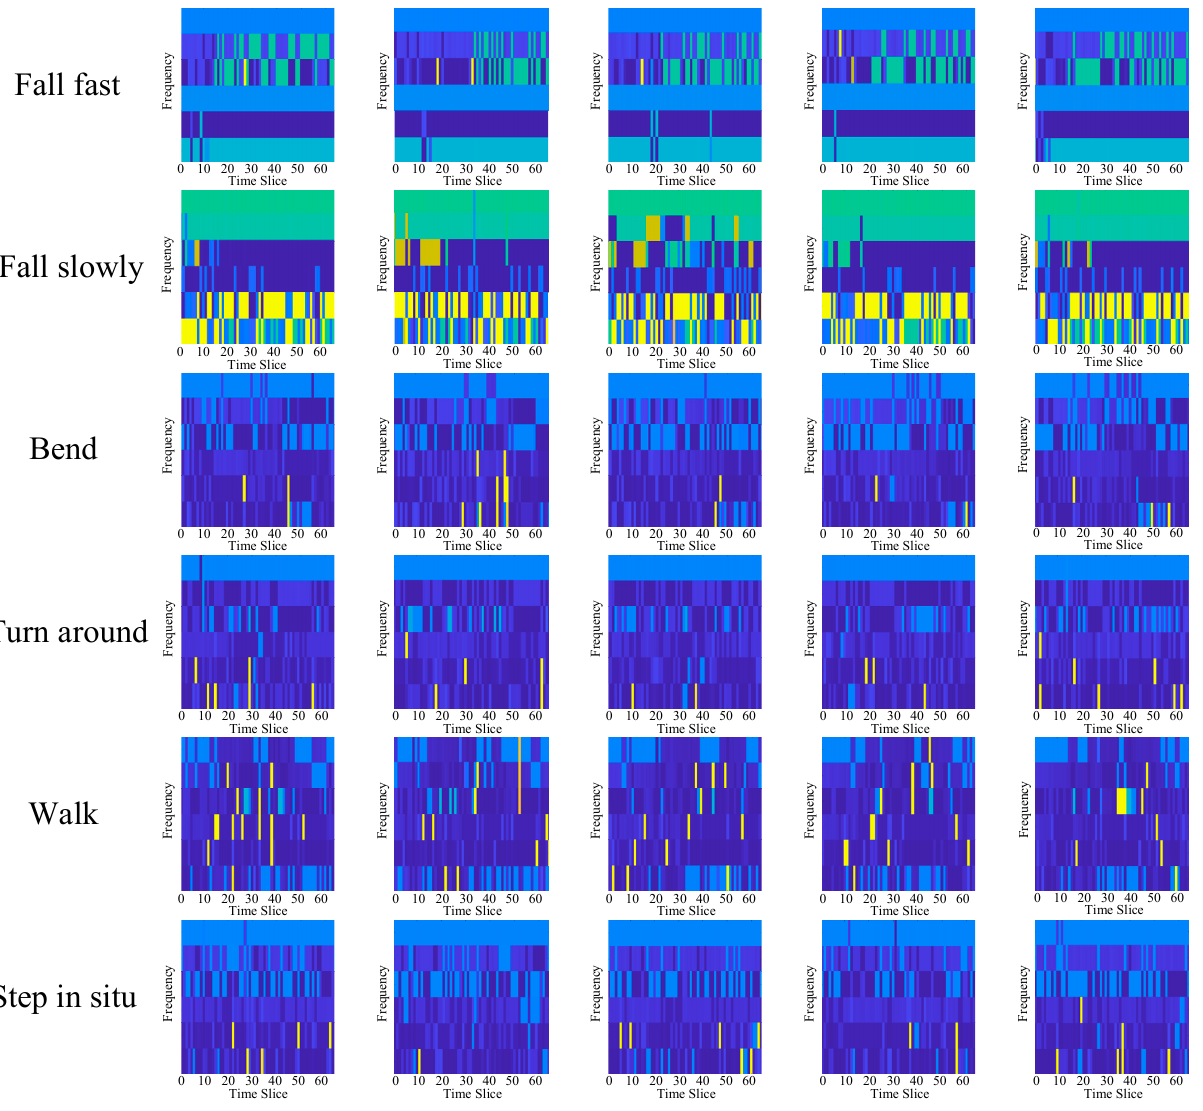
Figure 12. Characteristic images obtained by the Relax estimation for different actions. Additionally, to carry out further comparison and analysis, we also present the tra- ditional Micro-Doppler characteristic spectra of the TFD idea. As discussed in [30], the micro-motion of the target, such as vibration, rotation, and acceleration, will modulate the echo frequency and reveal some micro-Doppler characteristics. By using one-dimensional FFT and two-dimensional FFT on radar-echo data, respectively, micro-Doppler character- istic spectra of different actions were obtained and shown in Figure 13.